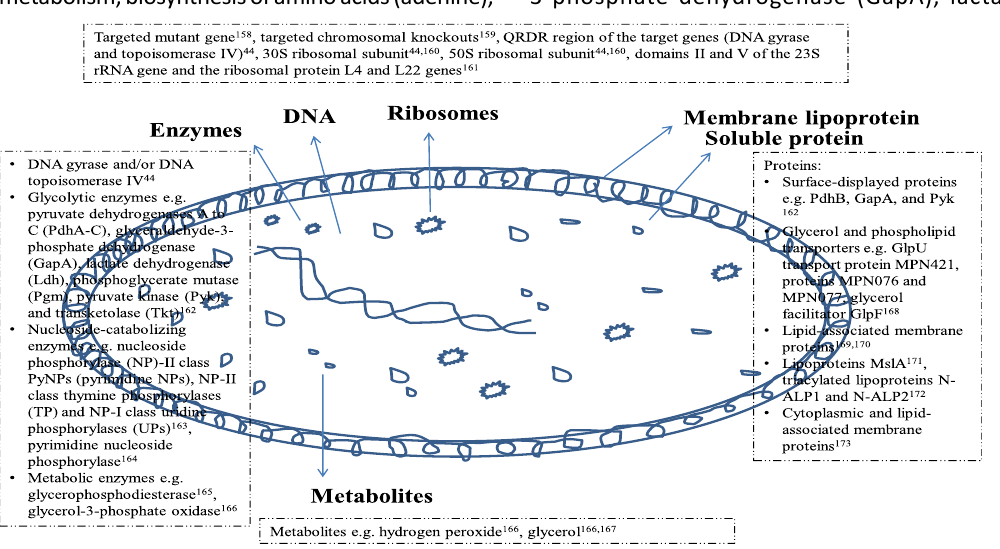
Fig. 1. Mycoplasma cellular structure and antimycoplasma